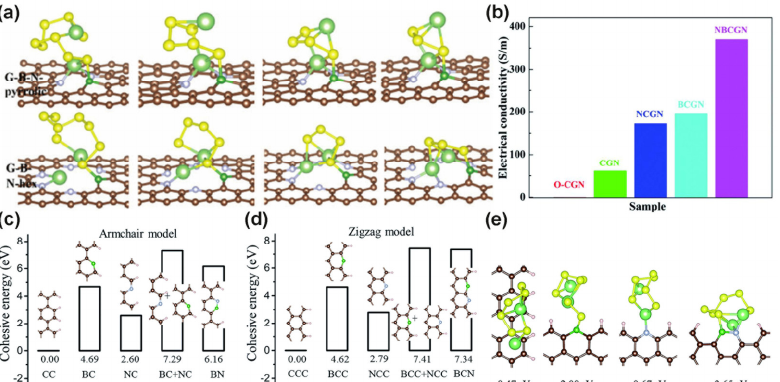
Figure 6. ( a ) Adsorption configurations of Li 2 S n (n = 3, 4, 5, 8) clusters on the G–B–N–pyrrolic and G–B–N–hex systems [88]. Copyright 2016, Royal Society of Chemistry. ( b ) Comparison of conductivity of graphene composites. Cohesive energy for each system of the armchair model ( c ) and zigzag model ( d ). Optimized adsorption structure of Li 2 S 6 on the pristine graphene edge, B doped system, N doped system, and N and B co-doped system as well as their binding energies ( e ) [64]. Copyright 2017, Royal Society of Chemistry.